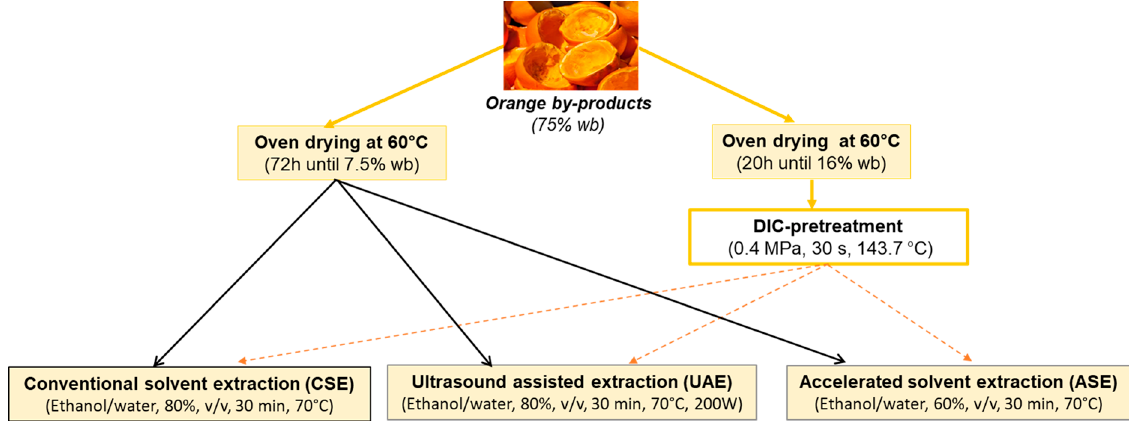
Figure 6. Orange by-products pretreatment and the used extraction methods.